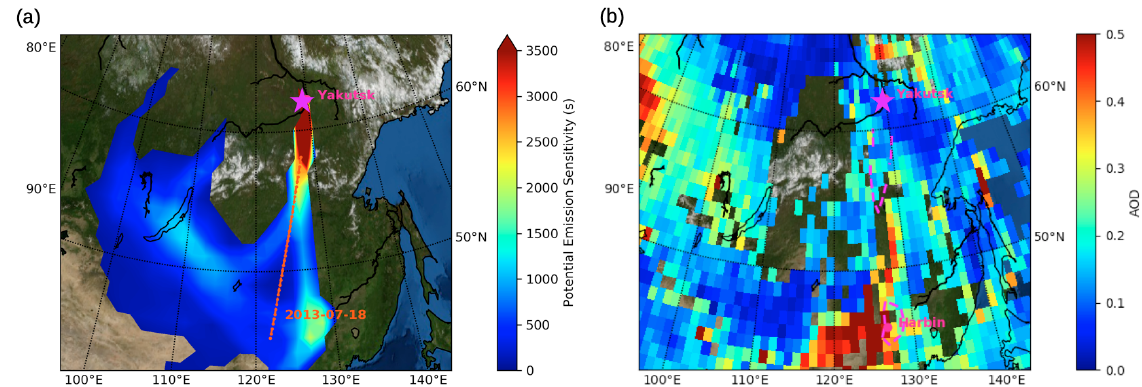
Figure 23. ( a ) as Figure 4a for the aerosol layer of Figure 22. Orange dotted line is the position of CALIOP overpass on 18 July 2013 at 18 U. ( b ) as Figure 4b with averaging of MODIS AOD 550 from 16 to 19 July 2013.